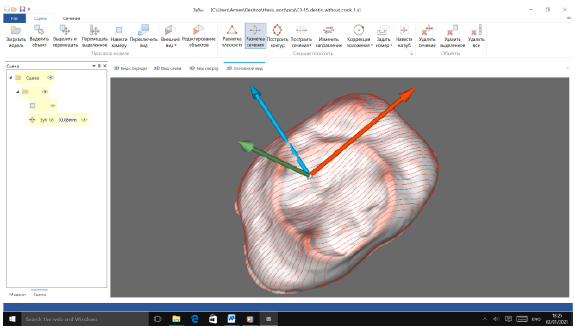
Figure 3. 40-slice sectioning on dentin reconstruction; the blue arrow indicates the longitudinal axis.